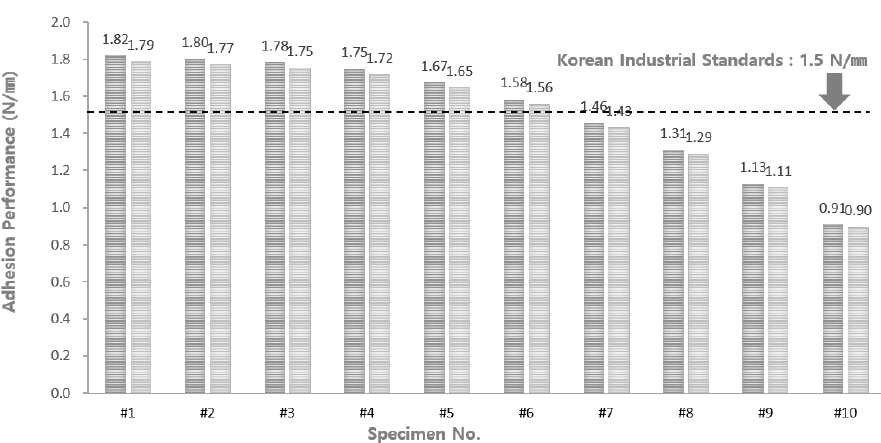
Figure 11. Adhesion performance test result of the alkali-treated sample.